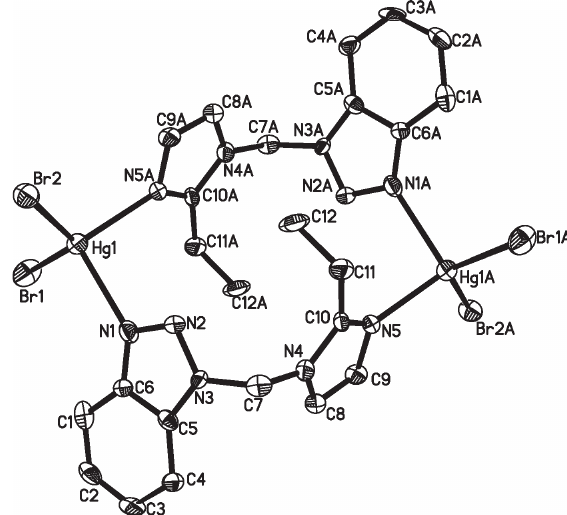
Table 1: Data collection and handling.